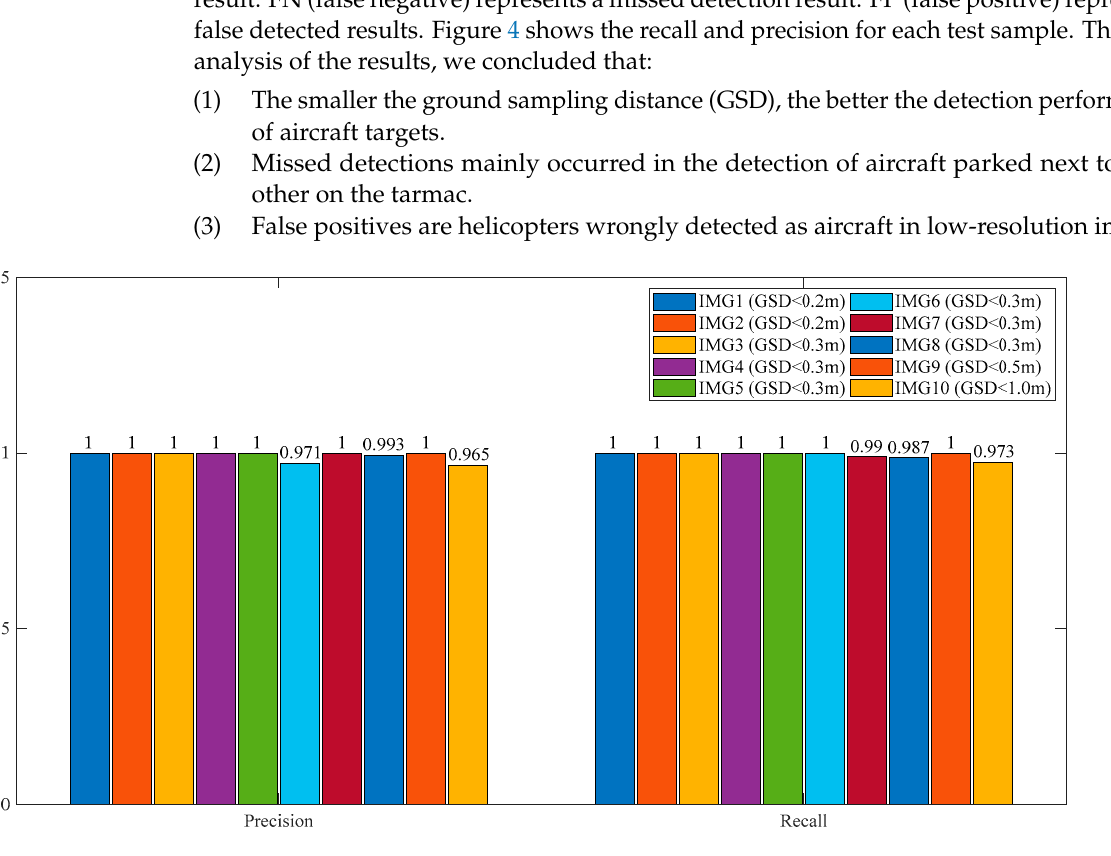
Figure 4. Precision and recall results of each test remote sensing image.